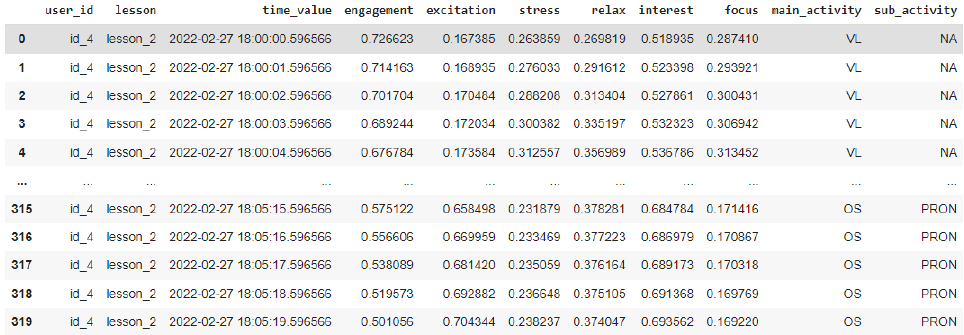
Figure 6. Annotated emotional data.